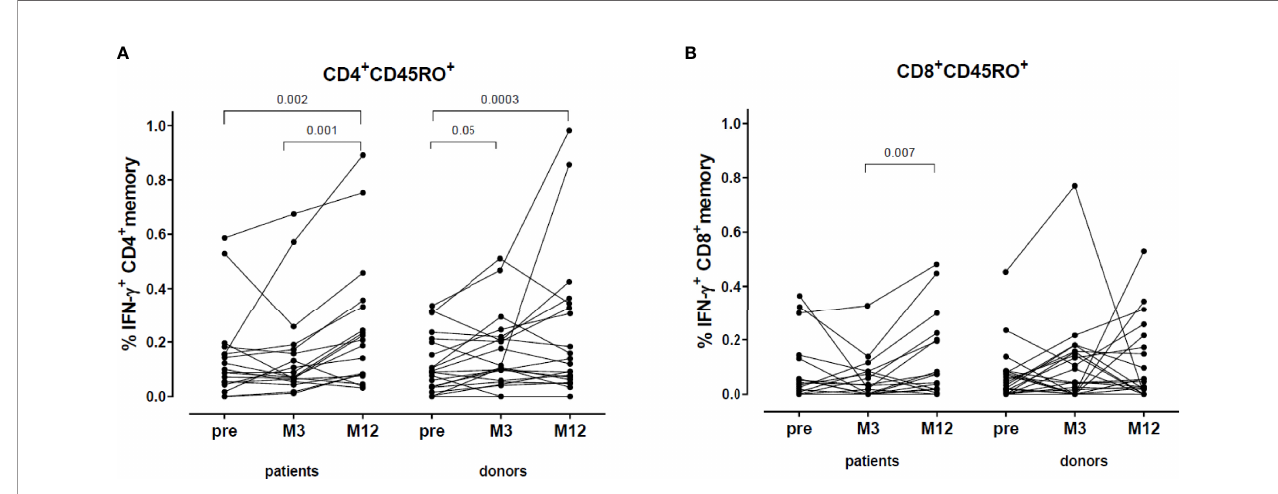
FIGURE 5 | VZV-reactive T cell response: CD4 + and CD8 + memory. (A) Percentage VZV-speci fi c IFN- g producing CD4 + memory cells. (B) Percentage VZV-speci fi c IFN- g producing CD8 + memory cells.